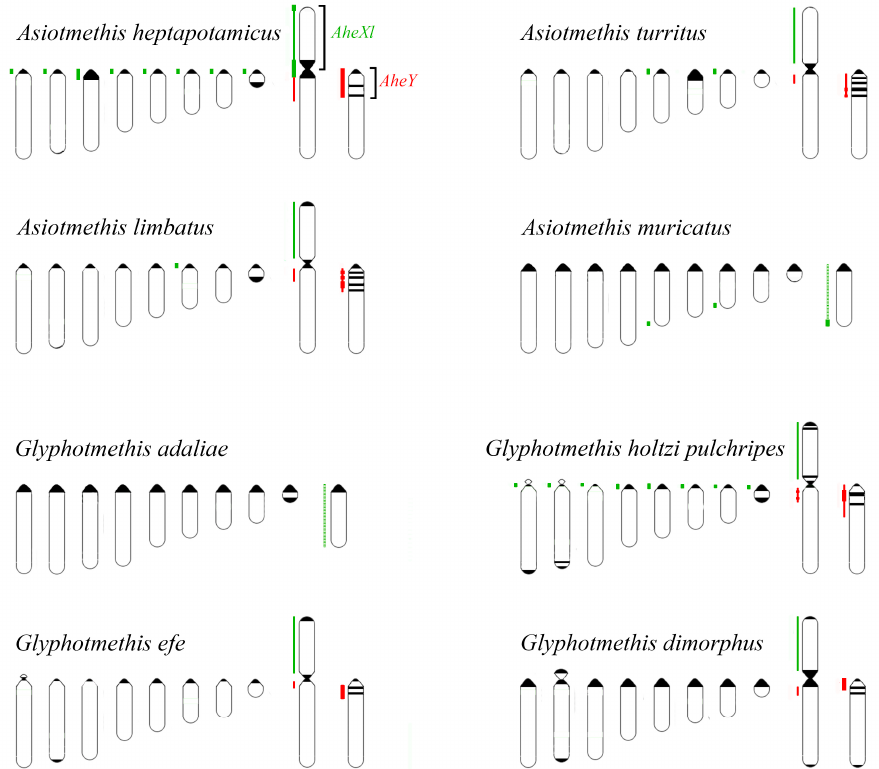
Figure 7. Schematic representation of chromosome painting results in Trinchinae species with AheXl (green) and AheYcen (red) DNA probes. The thick line shows intensive painting, while thin line shows less intensive painting. Black brackets indicate regions of microdissection. Distribution of C-positive regions on ideograms (black) is shown according to described earlier [23,24].